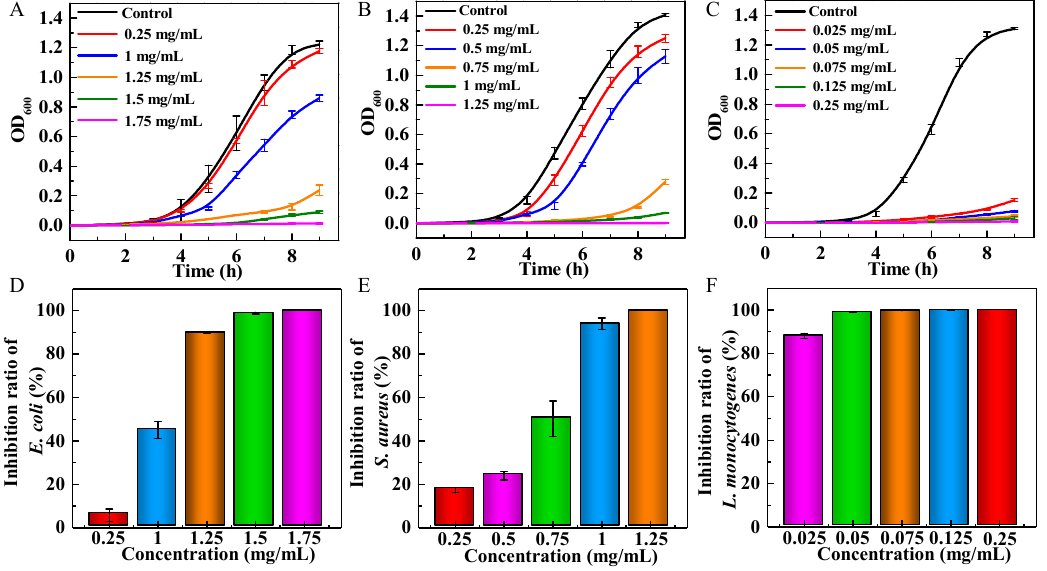
Figure 5. Bacterial growth curves and inhibition ratios of GS-MGO nanohybrids against E. coli (A and D), S. aureus (B and E) , and L. monocytogenes (C and F) with di ff erent concentrations.